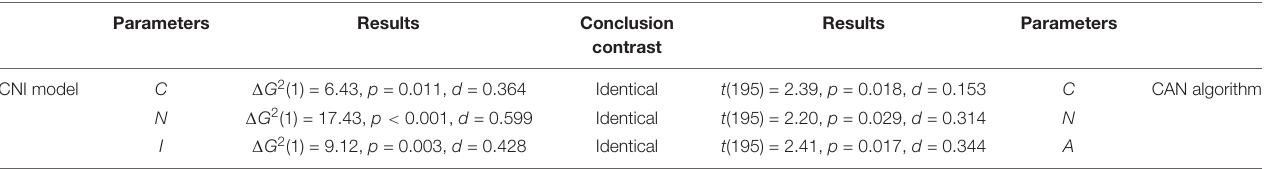
TABLE 2 | Test of gender differences with the CNI model and CAN algorithm in Study 1b by Gawronski et al. (2017).